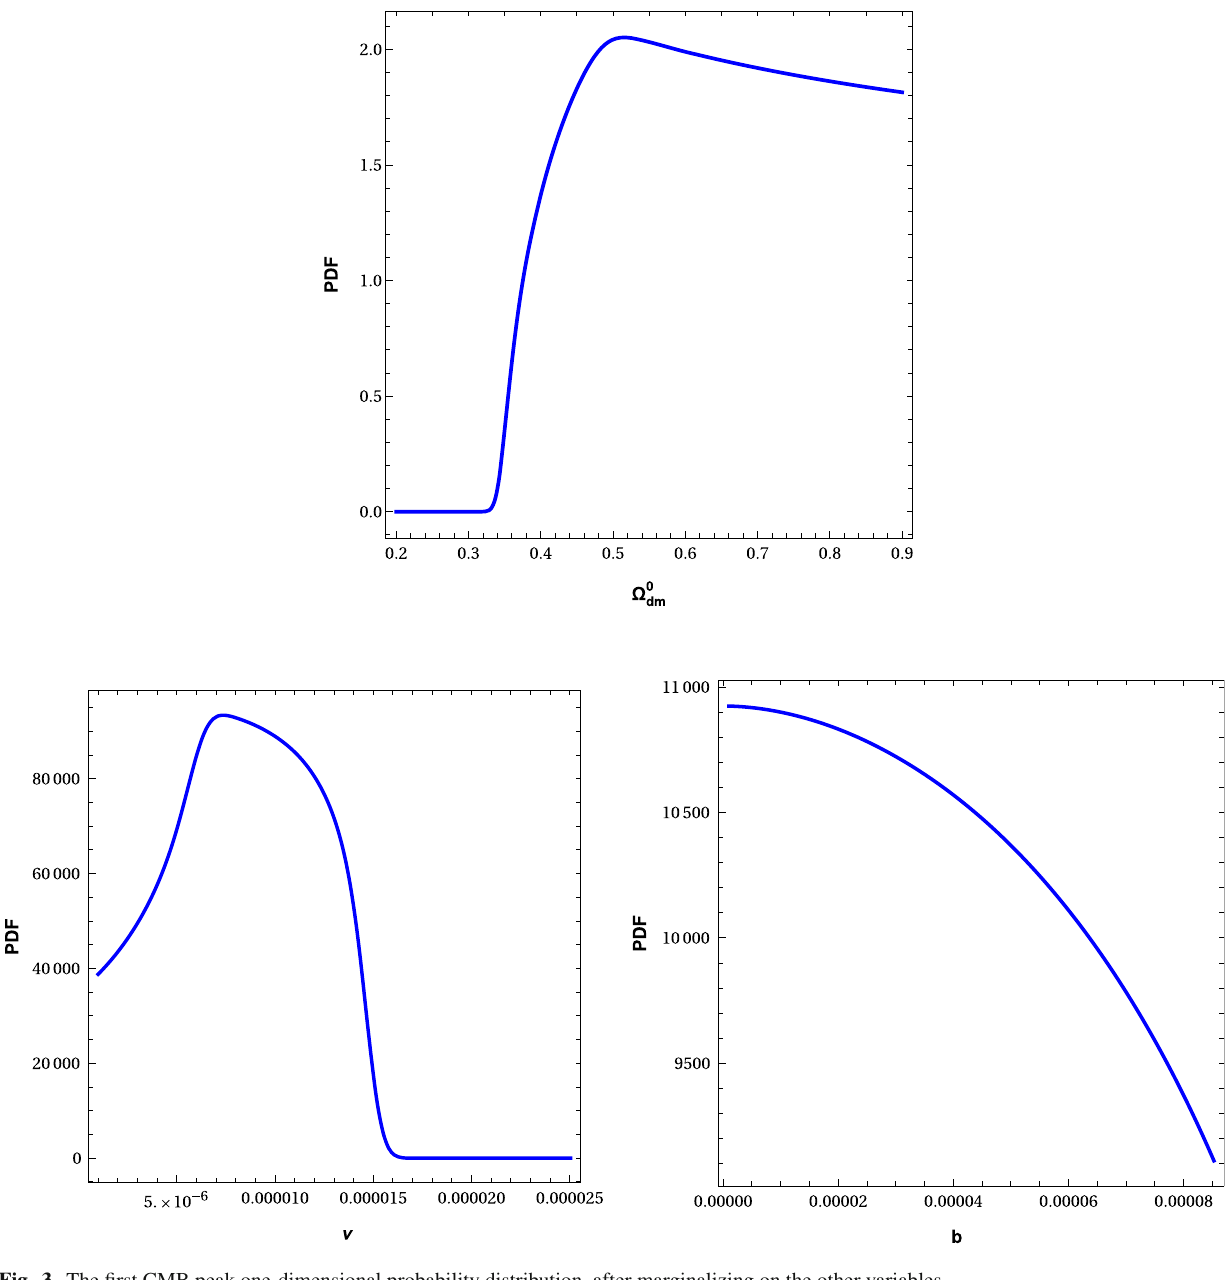
Two of the main statistical criteria to select models is the Akaike Information Criterion (AIC) [51], and the Bayesian Information Criterion (BIC) [52], defined respectively by, + 2 μ and BIC = χ 2 + 2 μ ln N , where AIC = χ 2 min min μ is the number of degree of freedom and N the number of observational data. These criteria take into account the number of free parameters of each model since the gen- eral tendency of models of higher number of free param- eters is to fit better the data. Frequently it is used on the Jeffreys scale [53] to quantify the relativity statistical